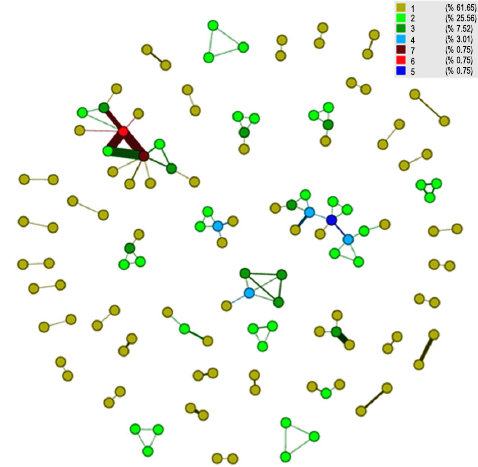
Fig. 3. Medium scale project network